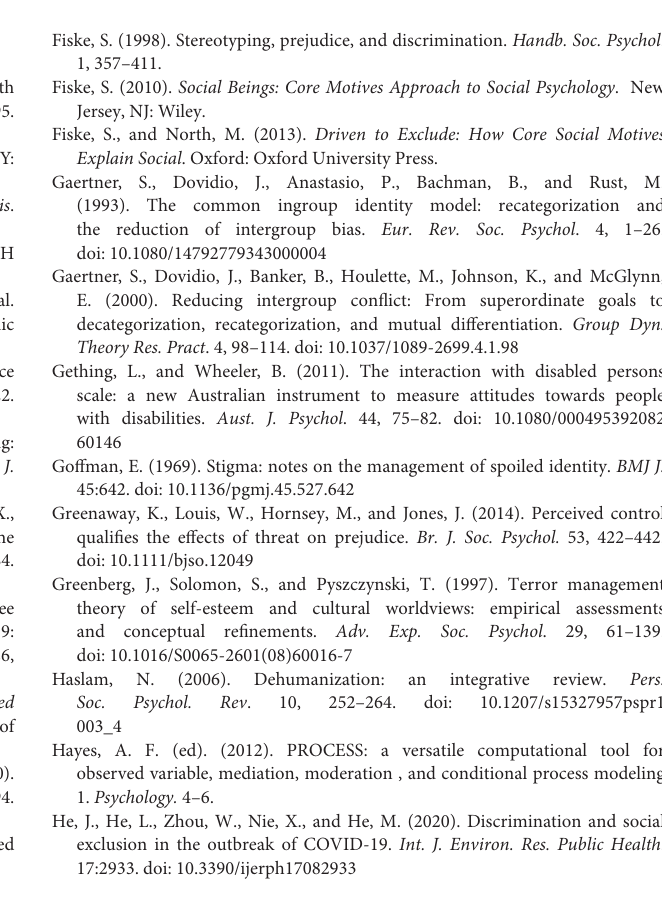
Supplementary Table 2 | Factor loadings from exploratory factor analysis. Supplementary Table 3 | Skewness and kurtosis. Supplementary Table 4 | Comparison of levels of stigmatization. Supplementary Table 5 | Summary of scores of